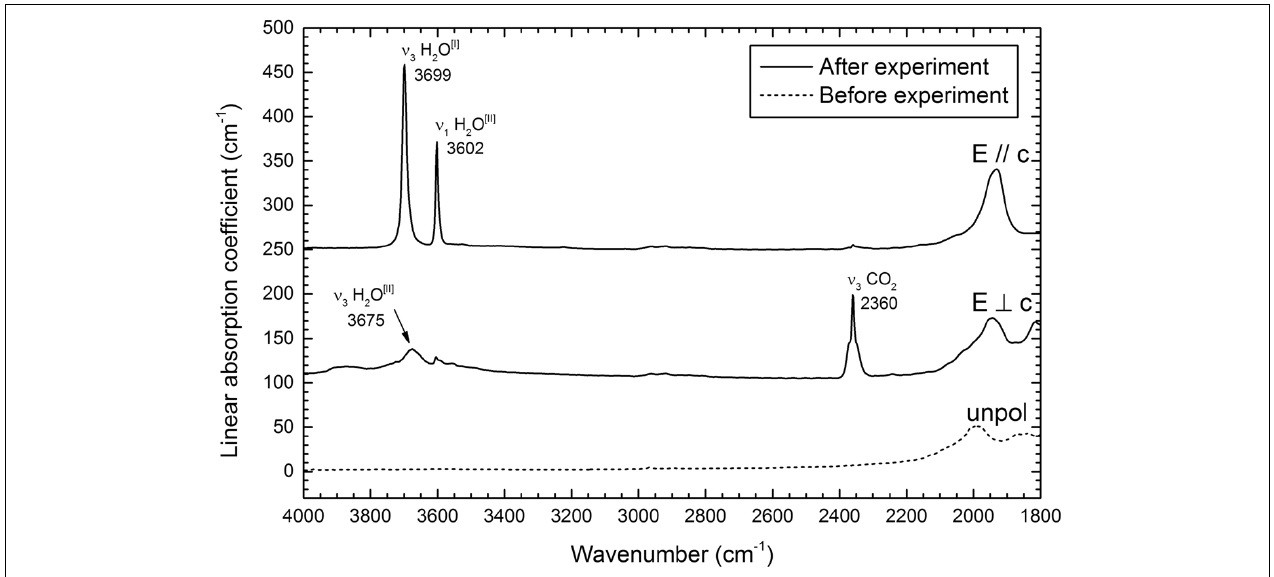
TABLE 2 | H 2 O and CO 2 maximum contents obtained for the studied beryl.